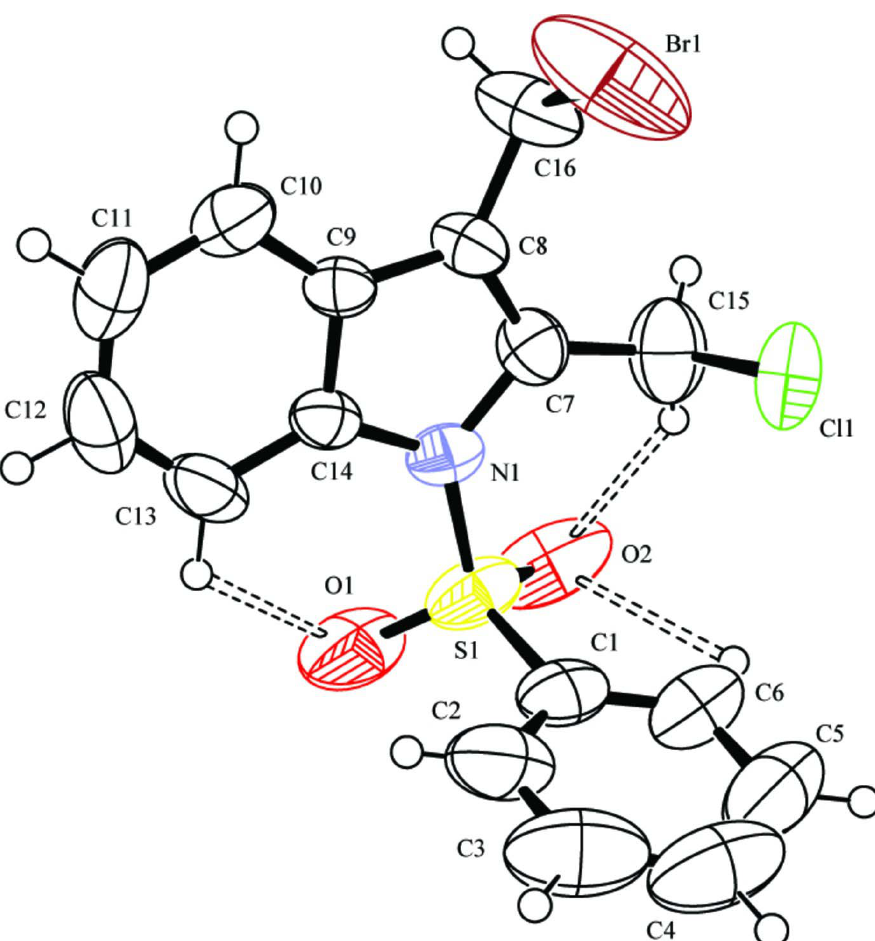
Figure 1 The molecular structure of (I) showing the atomic labels and 50% probability displacement ellipsoids for non-H atoms. Only major parts of the disordered atoms are drawn. Intramolecular H-bonds are shown as dashed lines. 3-Bromomethyl-2-chloromethyl-1-phenylsulfonyl-1 H -indole Crystal